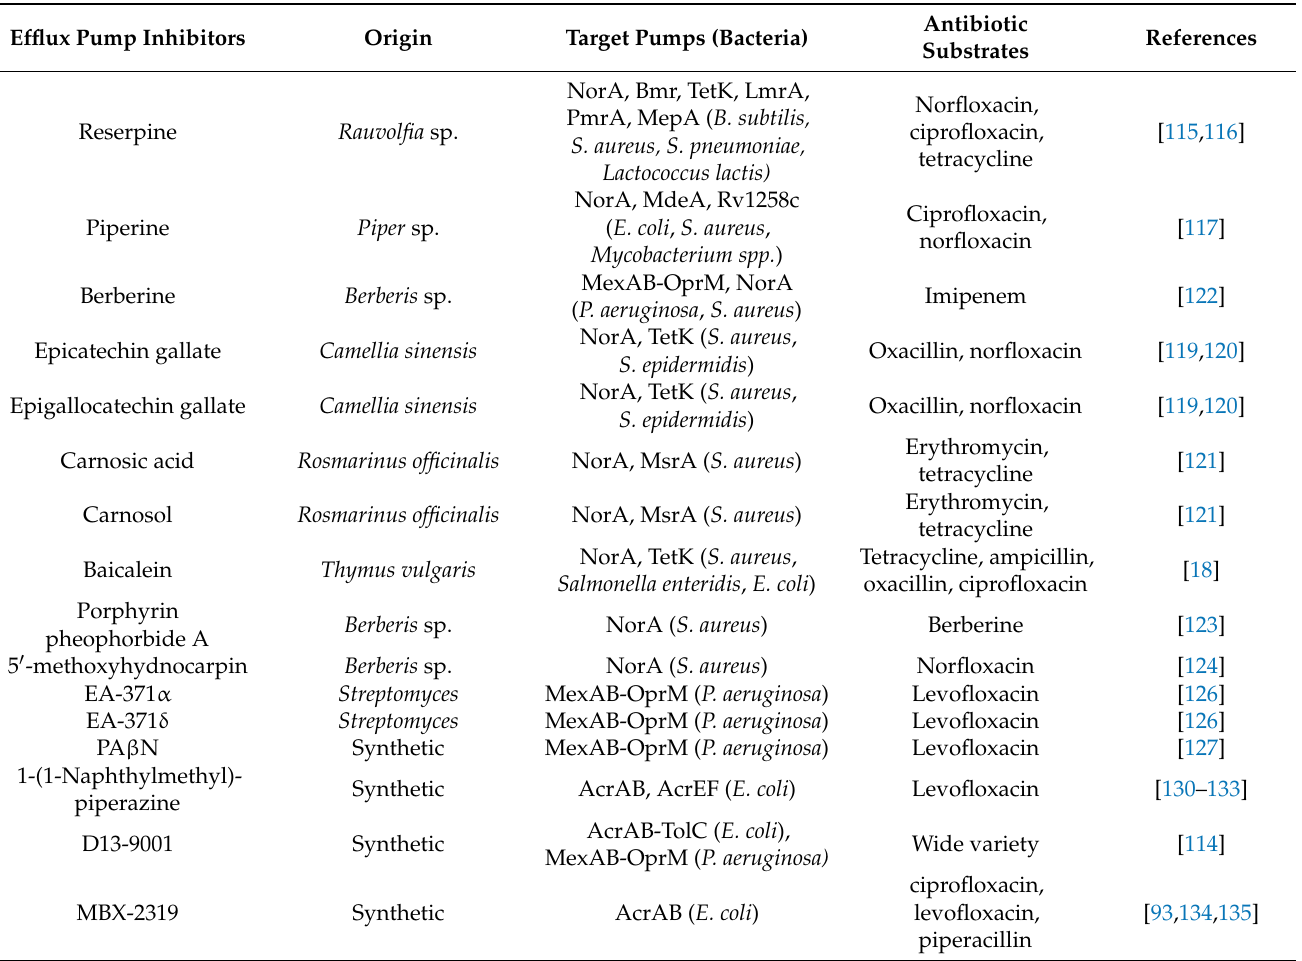
Table 1. Target pumps, and characteristic antibiotic substrates of some established efflux pump inhibitors from various